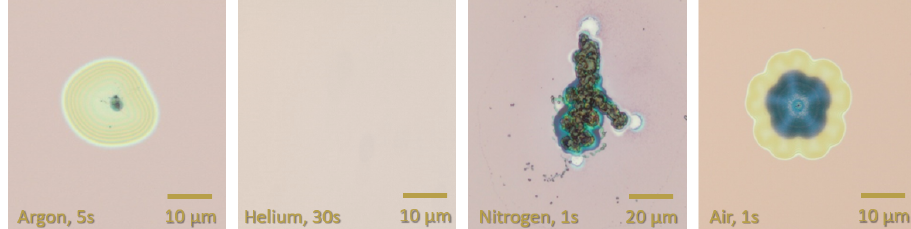
Figure 3. Microscope images of NPBS-coated samples treated with different DBDs generated with argon, helium, air and nitrogen.